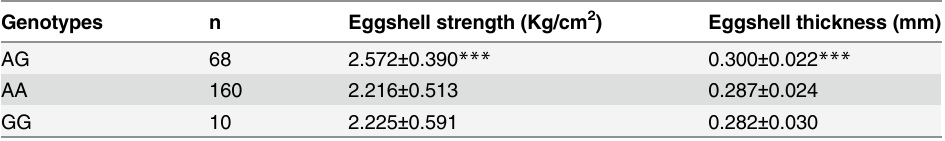
Table 3. Eggshell qualities of different genotypes for CACNA1H